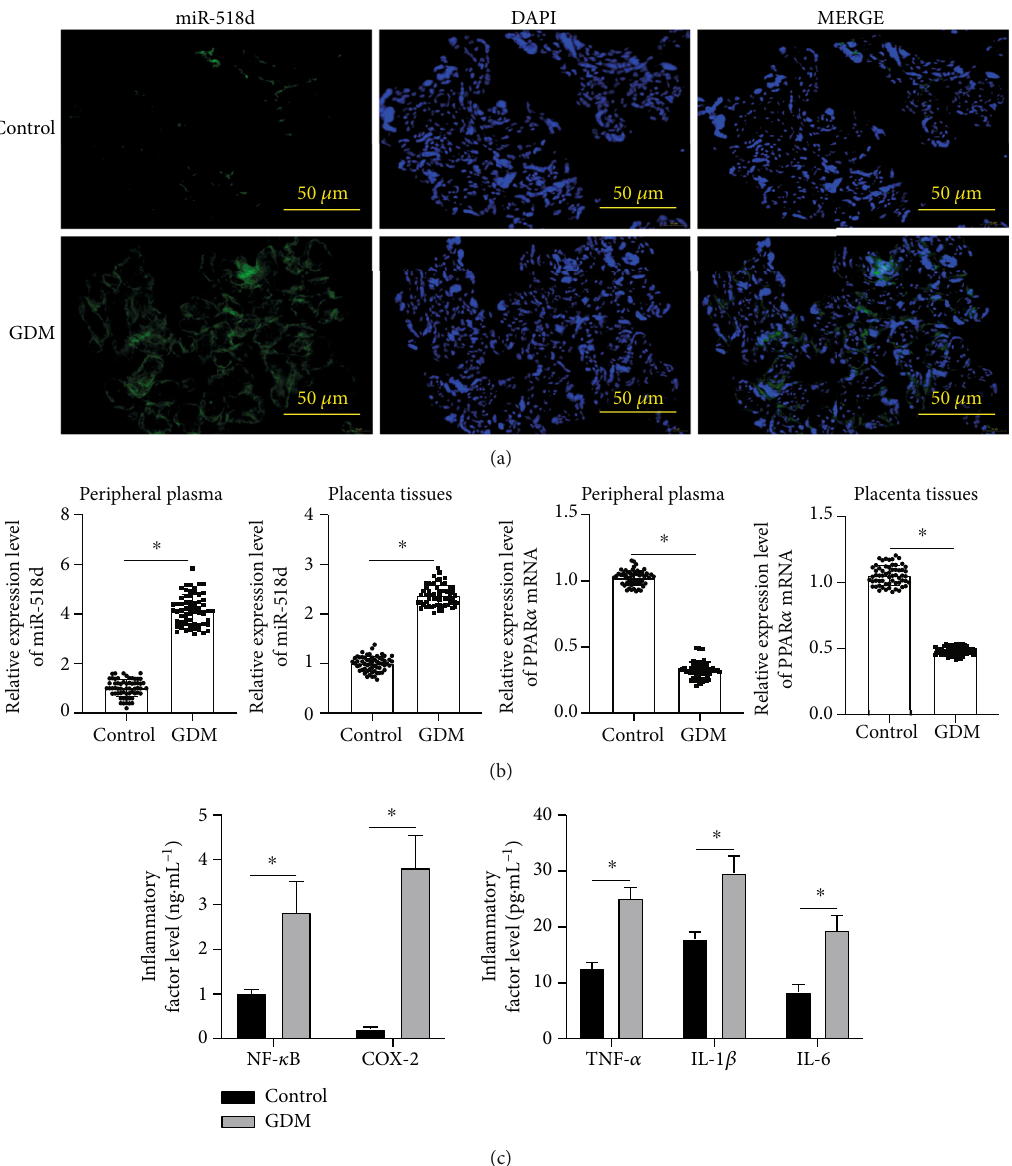
Figure 1: Regulatory e ff ects of miR-518d on pathological characteristics in GDM patients. (a) The expression of miR-518d in placenta tissues of pregnant women observed by the FISH assay (scale bar = 50 μ m ). (b) Expression levels of miR-518d and PPAR α in peripheral plasma and placenta tissues of pregnant women examined by RT-PCR. (c) Contents of in fl ammatory factors (NF- κ B, TNF- α , IL-1 β , IL-6, and COX-2) in peripheral plasma detected by ELISA. All data were represented as mean ± SD . ∗ p < 0 : 05